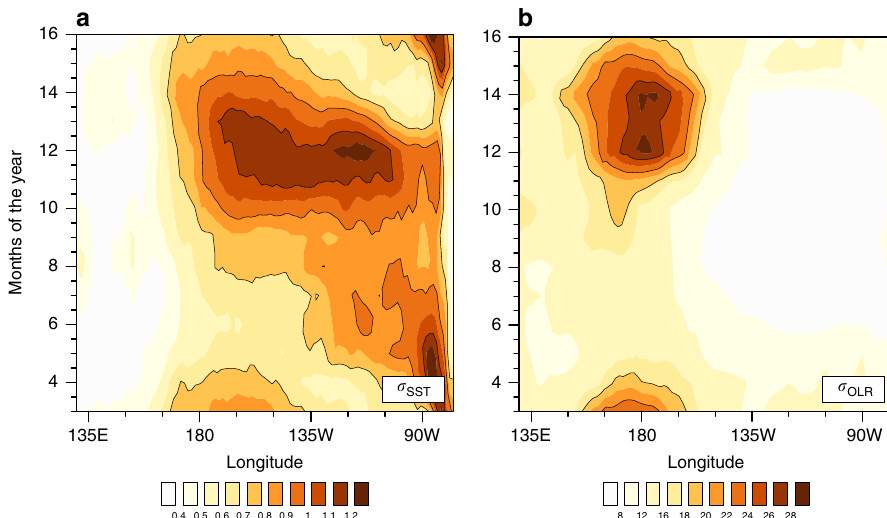
Fig. 1 Seasonal cycle of the standard deviation of interannual equatorial Paci fi c SST and outgoing longwave radiation anomalies. The seasonal cycle of standard deviation for a SST (unit: K) and b outgoing longwave radiation (OLR, unit W m − 2 ) is presented from March, instead of from January — this represents the ENSO signature around the peak of its variations better. Monthly SST anomalies 55 and OLR anomalies 56 for the period 1982 to 2015 were used in the calculation. Before we calculated their standard deviations, we averaged SST anomalies and OLR anomalies over 5°S to 5°N. The data for all months of 1982 and 1997 were excluded from the